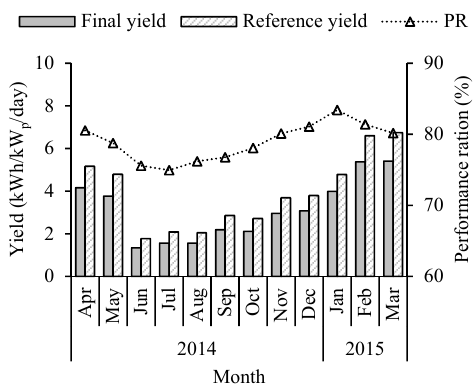
Figure 2. Monthly average daily value of final and reference yields and monthly performance ratio of the HCPV system.